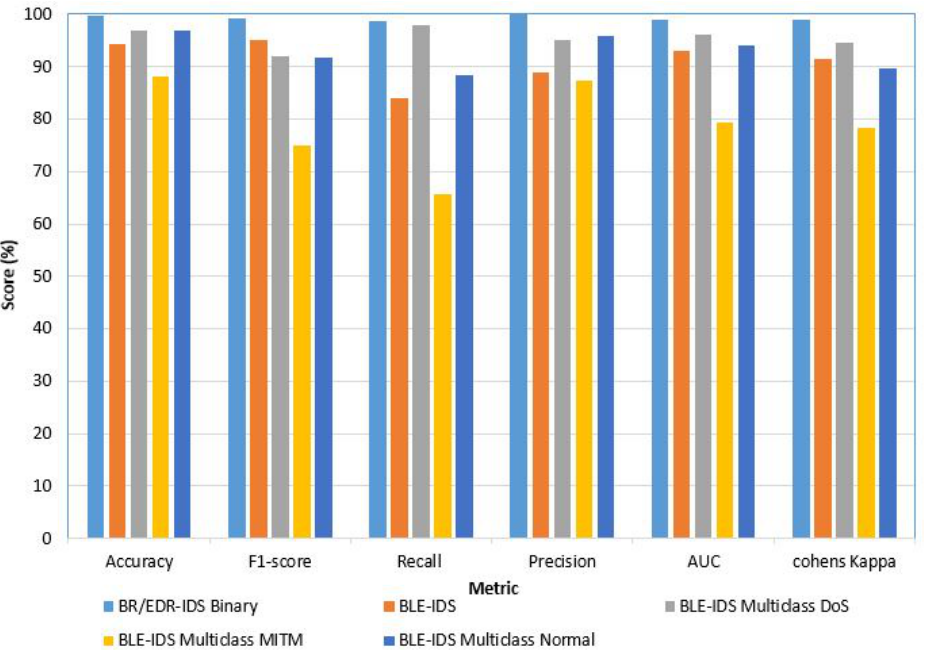
Figure 11. Performance analysis of the binary and multiclass of the proposed model for BR/EDR and BLE, respectively. Table 11. Comparison of our model with existing IDS